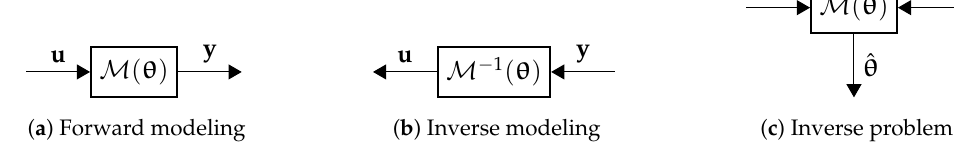
Figure 1. Illustration of the different principles of a standard process simulation configuration ( a ), the inverse modeling setting to reconstruct system inputs ( b ), and the inverse problem for parameter identification ( c